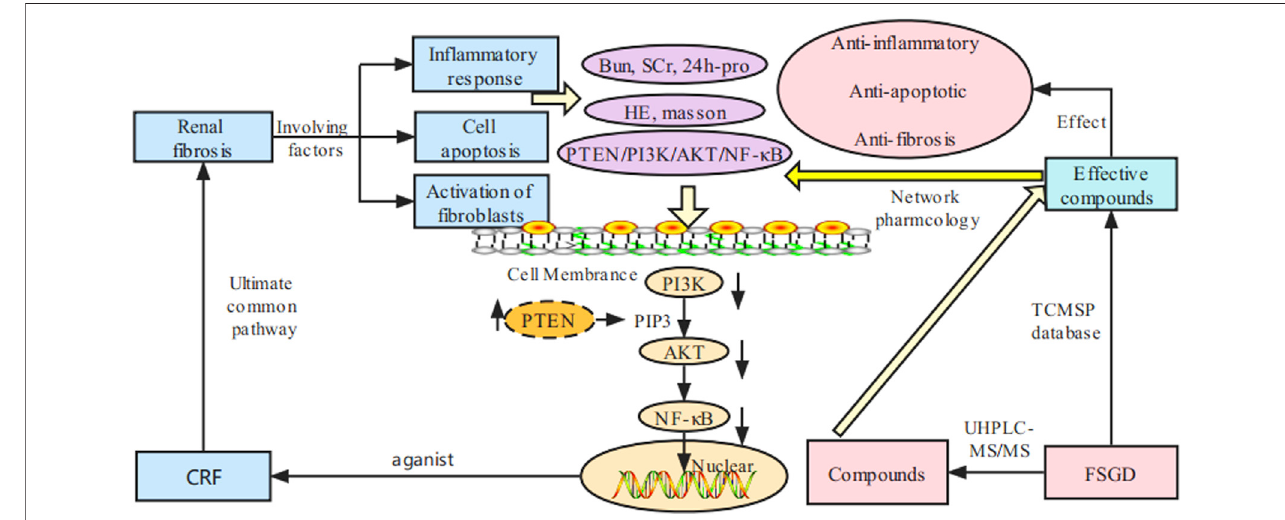
FIGURE 8 | Schematic representation of molecular pathway of FSGD in